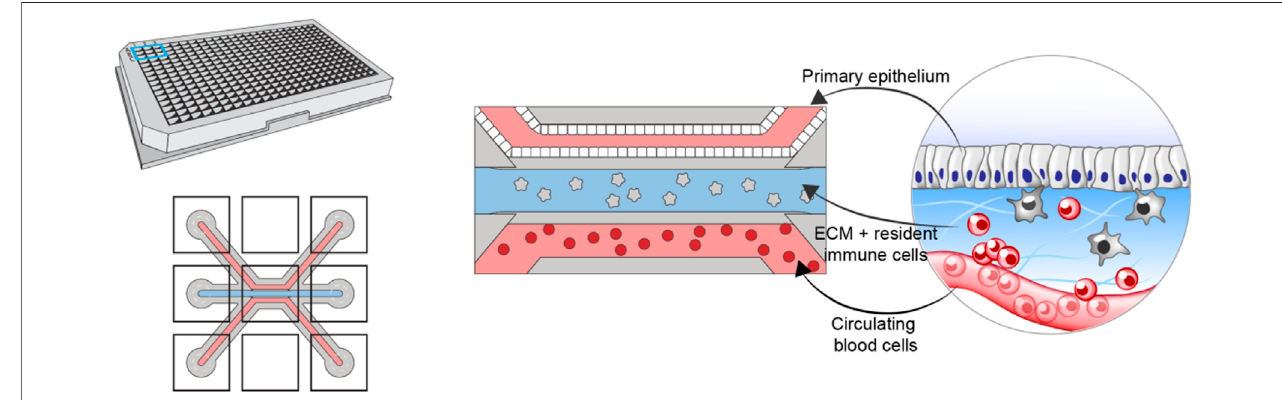
FIGURE 1 | Schematic showing the design and layout of the Mimetas Organoplate chip and the components comprising each of the three channels of each well — primary gut epithelium in the top channel, extracellular matrix and resident immune cells in the middle channel, and peripheral blood mononuclear cells in the bottom